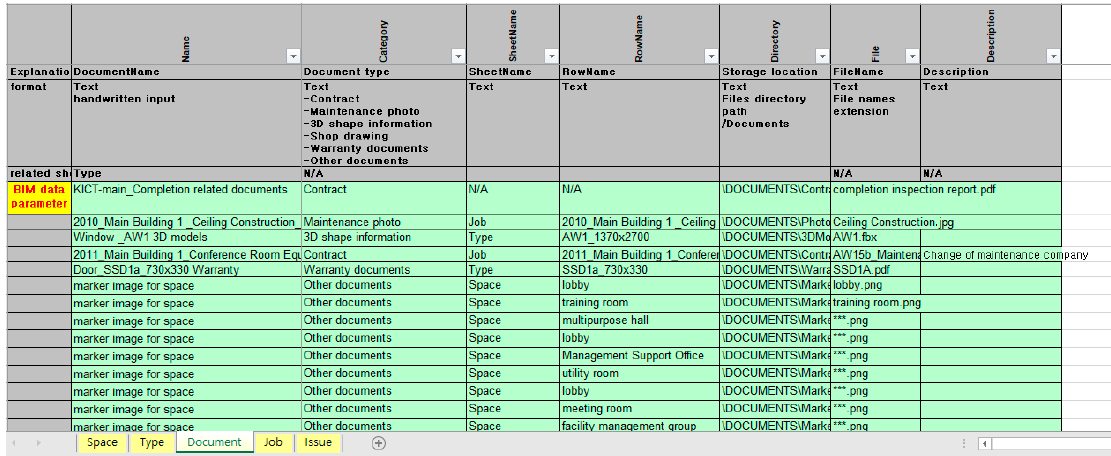
Figure A1 . COBie ‘Document’ datasheet. Figure A1. COBie ‘Document’